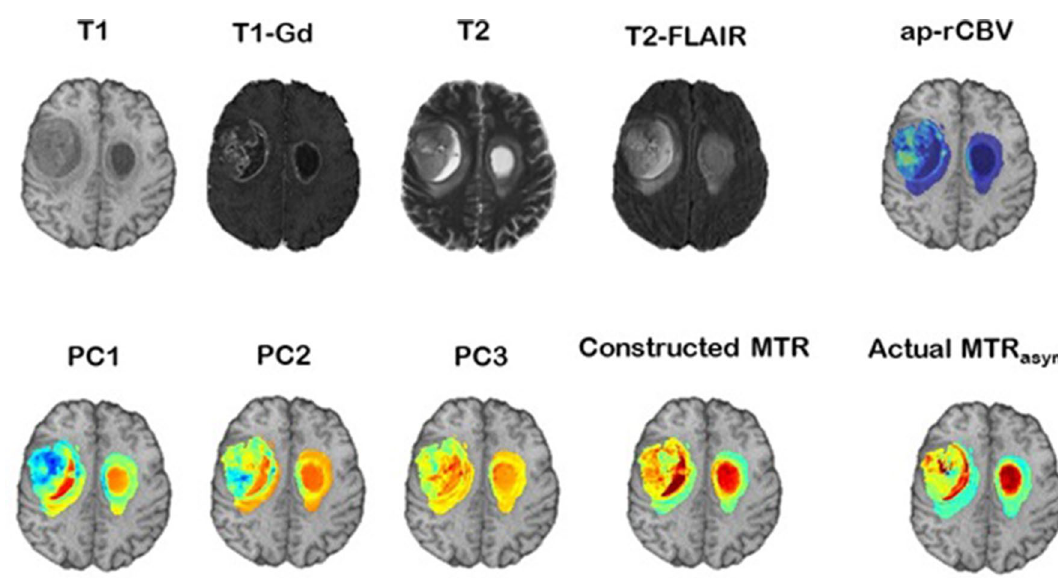
Figure 2. Conventional MRI, including T1, T1-Gd, T2, and T2-FLAIR, scans of a 58-year-old male patient included in our study. Map of a proxy to relative cerebral blood volume (ap-rCBV) derived from DSC-MRI scans with CaPTk software. Three principal components (PCs), PC1 to PC3, calculated using PCA of the hemodynamic perfusion curves, along with the MTR asym image constructed using the seven PCs in association with the actual MTR asym image. CaPTk version 1.8.1 (www. med. upenn. edu/ cbica/